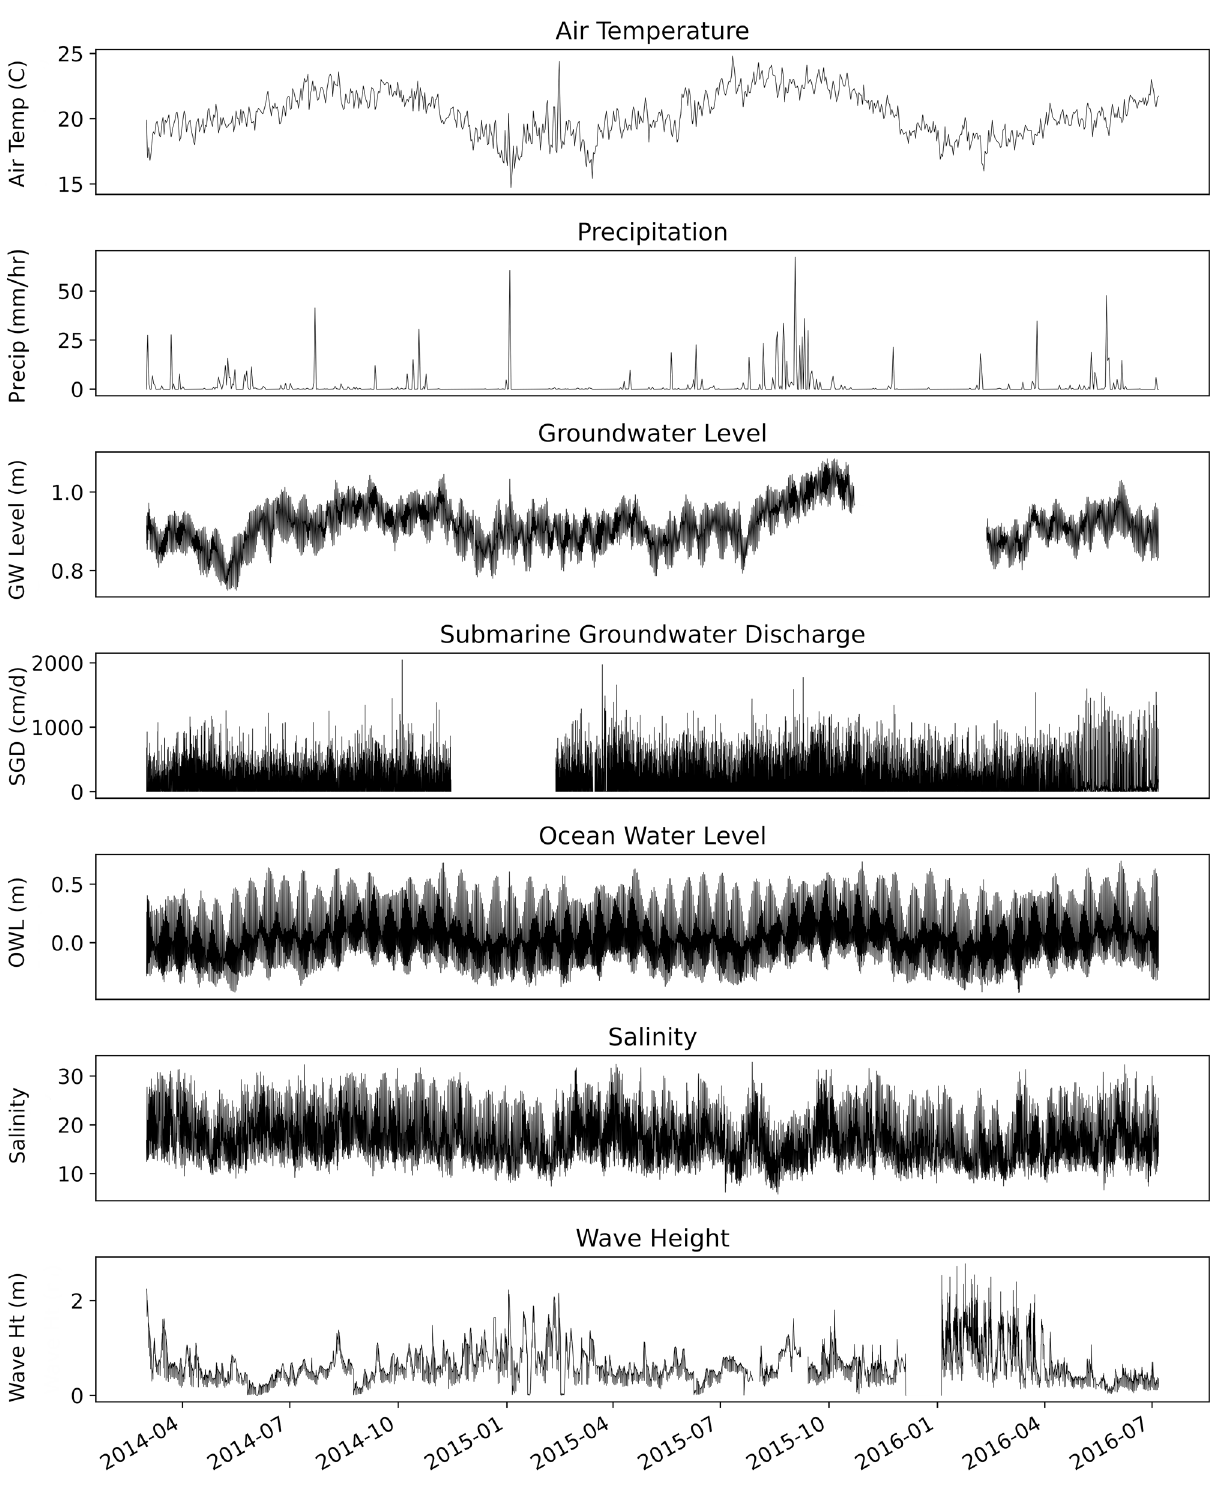
Figure 3. 1 h resolution data. Air temperature ( o C), precipitation (mm/hr), groundwater level (m), SGD (cm/d), ocean water level (m), salinity, and wave height (m) are shown with respect to time. Average uncertainty for SGD was ±